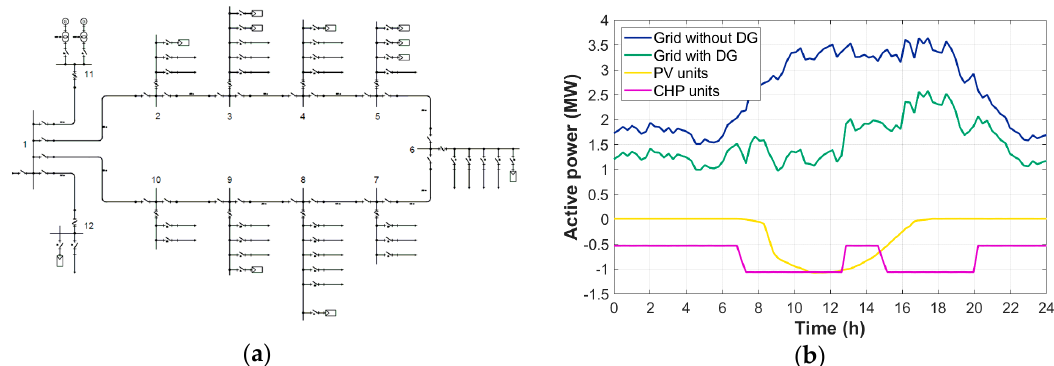
Figure 7. ( a ) the University of Salerno (UniSA) campus power grid; ( b ) Active power absorbed by the UniSA microgrid.